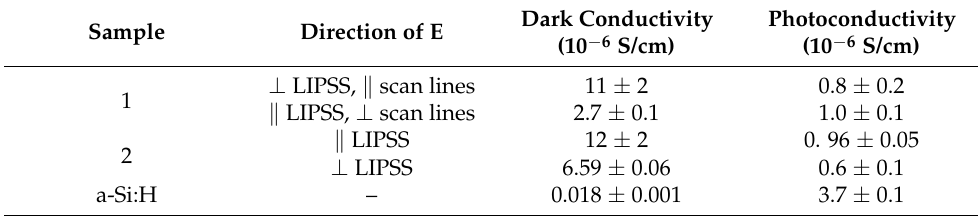
Table 3. Dark conductivity and photoconductivity for the samples 1, 2 for different directions of the applied electric field E relative to LIPSS and scan lines, and for the unmodified a-Si:H film. The data is obtained at room temperature (293